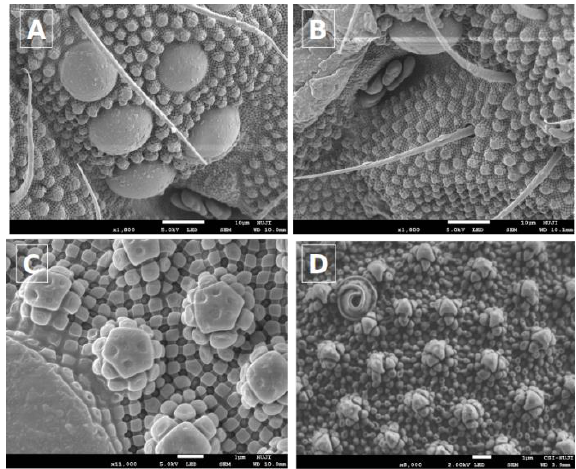
Figure 4. SEM images of a springtail. ( A ) and ( B ) magnified view of the compound eyes of a springtail, including microscale hairs and so-called secondary granules, with a scale bar of 10 microns. ( C ) Magnified image of a snow flea cuticle showing the network pattern of lower primary granules located between the secondary granules. ( D ) Magnified view of a springtail’s dorsal cuticle. The scale bar for ( C ) and ( D ) is 1 micron.